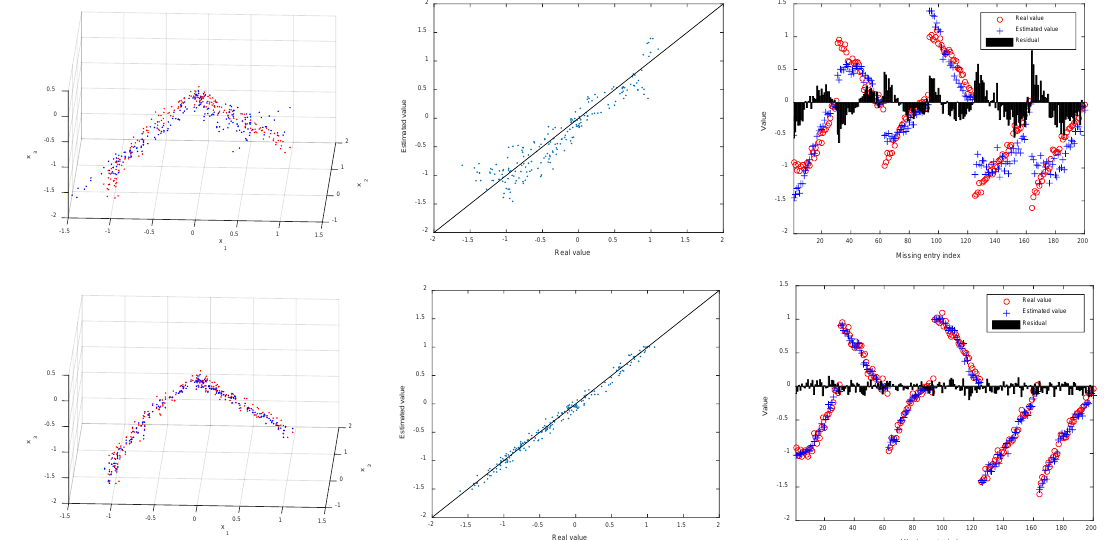
Figure 3. Imputation results obtained by local least squares (LLS), low-rank matrix completion (LRMC), probability principal component analysis (PPCA), sparse representation with elastic net regularization (SR-EN), and kernel sparse representation with elastic net regularization (KSR-EN) (from top to bottom ). Table 1. Imputation error root mean square error (RMSE) and relative error (RELERR) obtained by different approaches. The best results are highlighted in